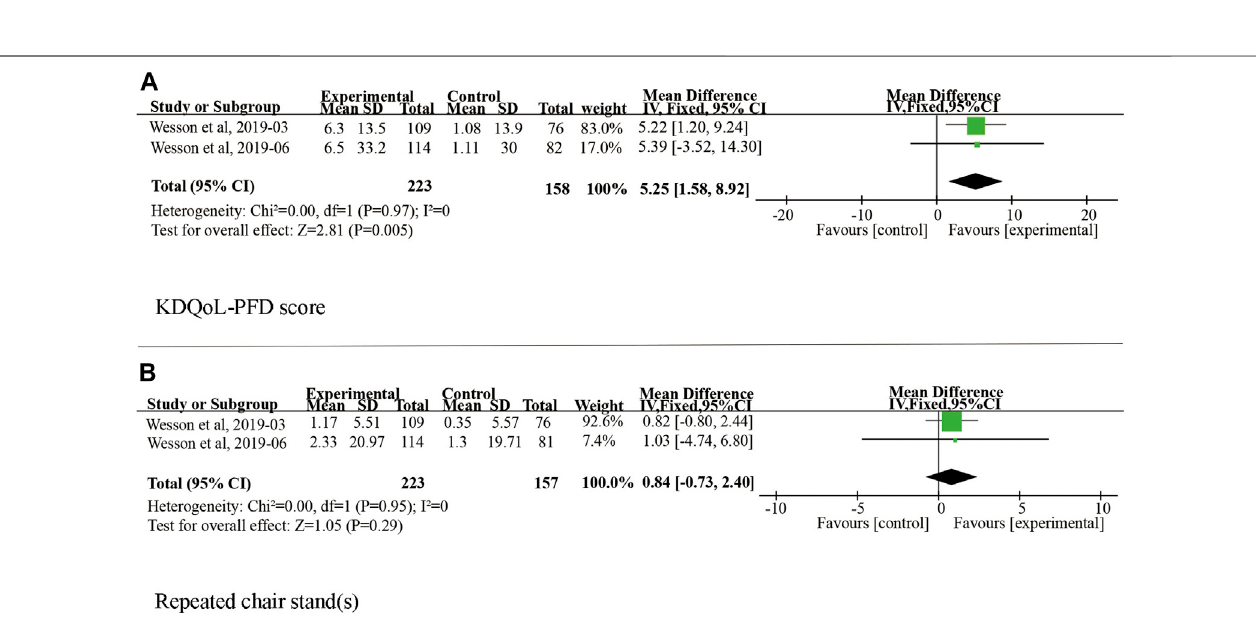
FIGURE5| Forestplotforchangeinphysicalfunction. (A) DifferenceinKDQoL-PFDscoreamongstudiesincluded inthemeta-analysis. (B) Differenceinrepeated chair stand (s) among studies included in the meta-analysis. IV, independent variable method; 95% CI, 95% con fi dence interval.